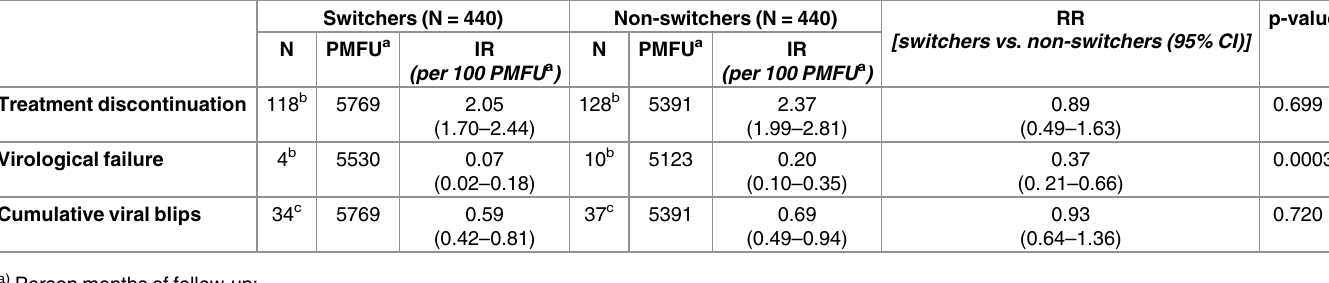
Table 2. Incidence rates and relative risks of the main